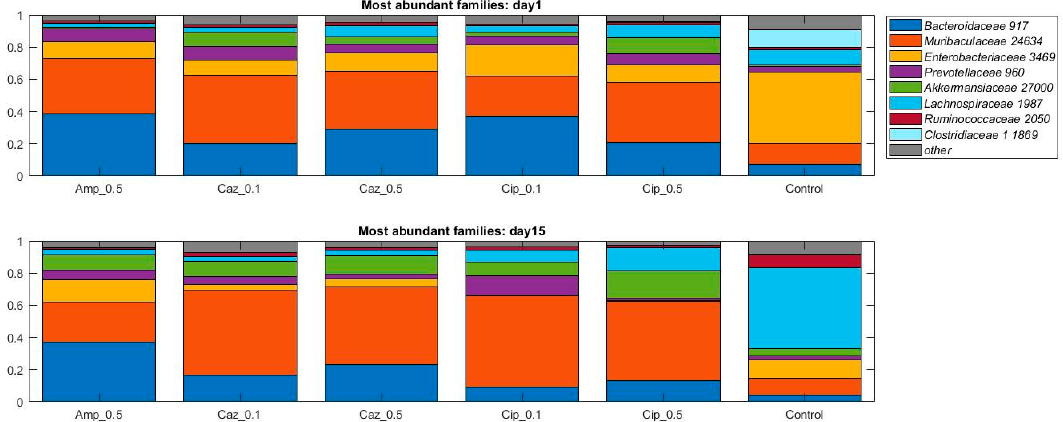
Figure 3. Relative abundances of the eight most abundant taxonomic families in the dataset over time. Average values of relative abundances at the family level were calculated for samples from the same treatment groups. Elements are shown if they have at least 5% relative abundance in at least one of the averaged samples.